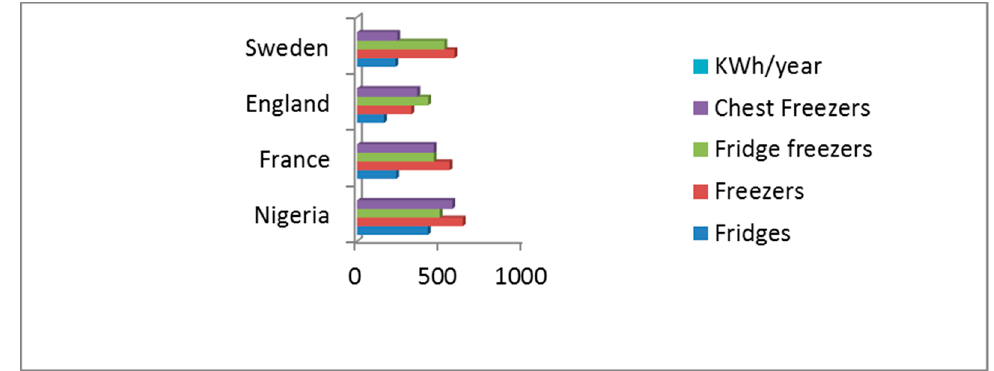
Figure 4. Comparison of the consumption of cold appliances in Nigeria with other countries (Source: [5]).